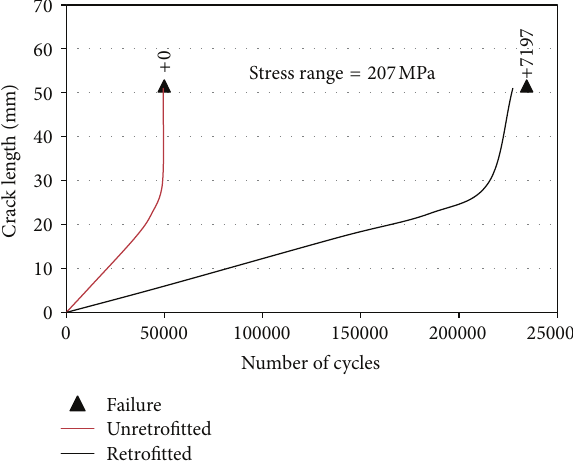
Figure 7: Fatigue crack growth curve for unreinforced and rein- forced steel beams